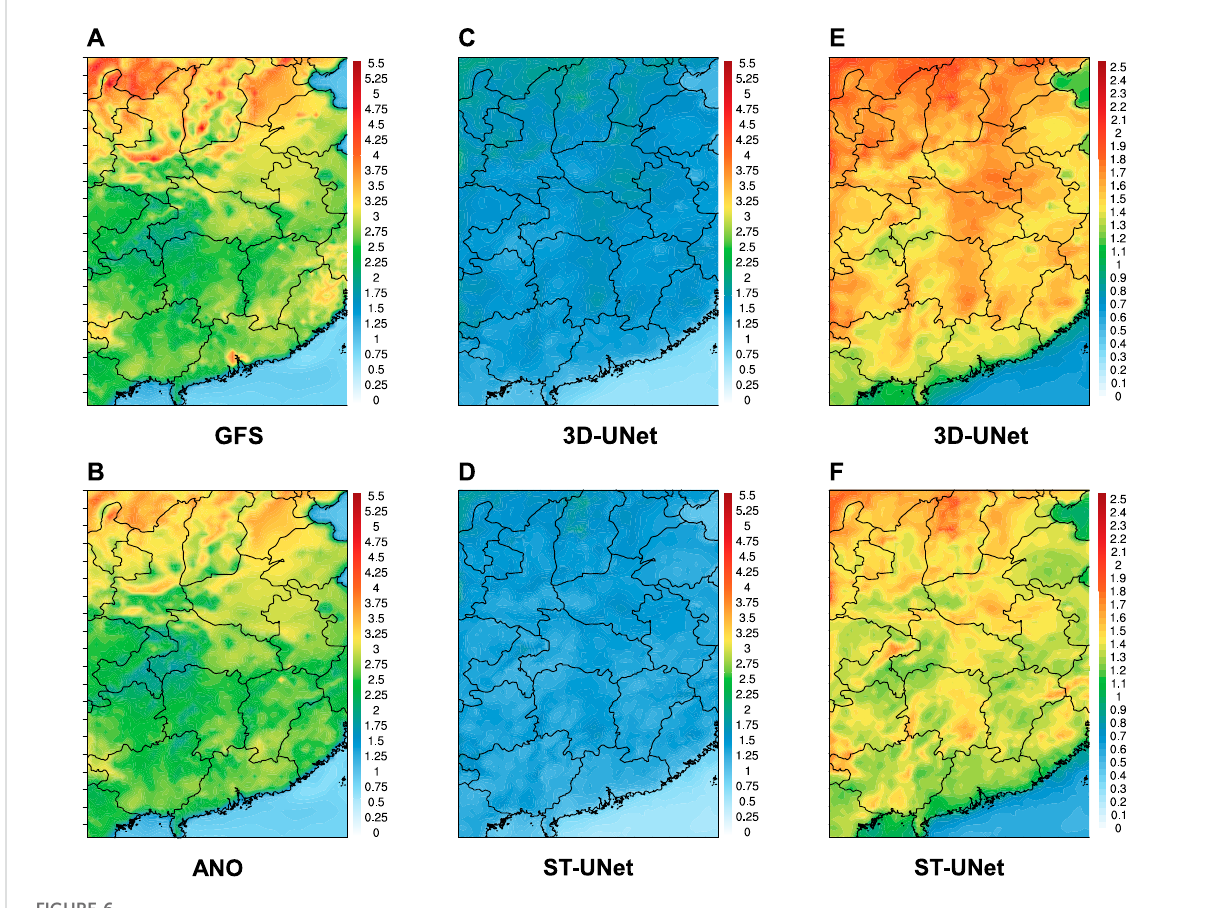
FIGURE 6 The RMSE spatial distributions of bias correction for 2-m temperature on the test set over study